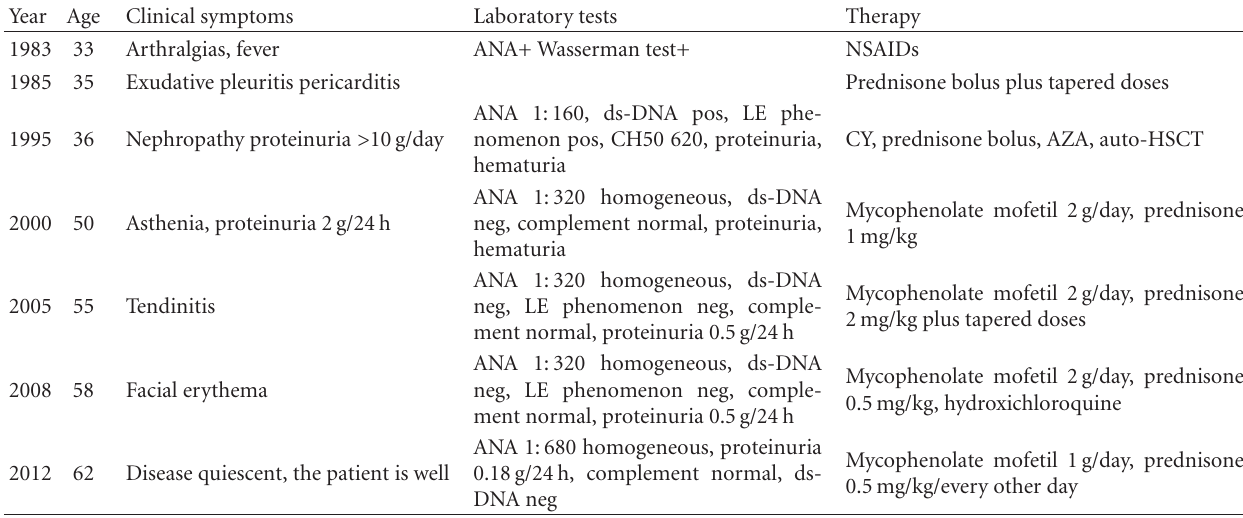
Table 1: A synthesis of the first case of SE performed in Genoa, with a followup of 16